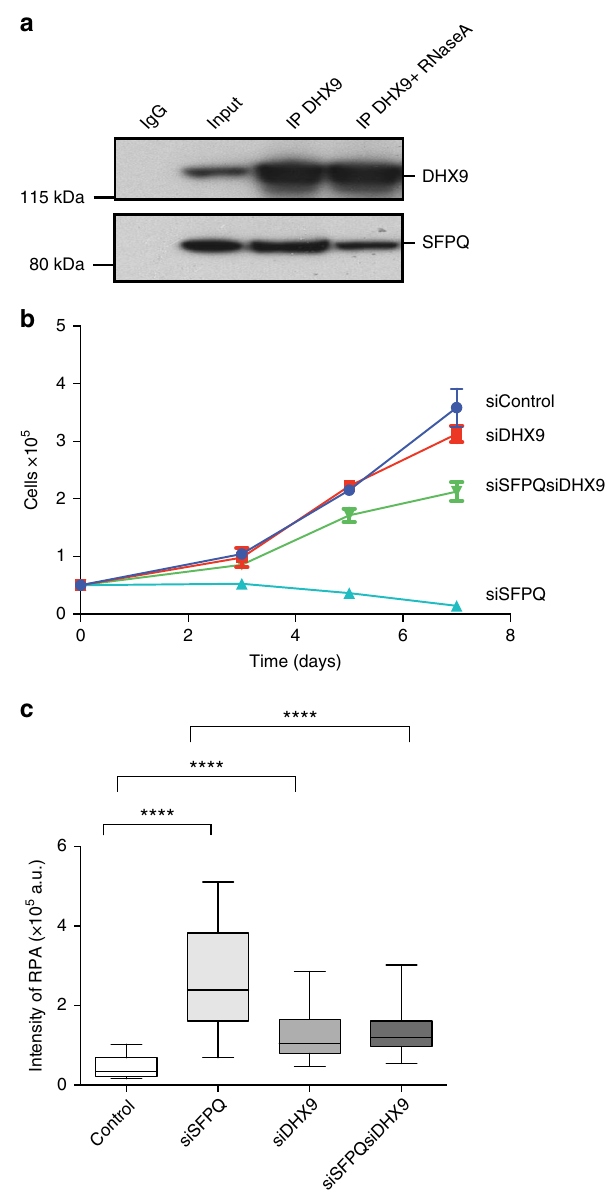
Fig. 5 DHX9 interacts with SFPQ. a Western blot showing co- immunoprecipitation of SFPQ with DHX9 from Hela cell nuclear extract. Control sample treated with RNaseA is indicated. Input sample and IgG control are also shown. b Knockdown of DHX9 suppresses the growth defect in SFPQ-depleted cells (siSFPQ8). Cell number was measured 48 h after transfection with siRNA (time 0) and again after 3, 5, and 7 days. c Knockdown of DHX9 suppresses replication stress in SFPQ-depleted cells. Fluorescence intensity of RPA foci was measured in n > 90 cells, 72 h after transfection with the indicated siRNA. Statistical signi fi cance was determined using Mann – Whitney test (**** p < 0.0001). Box and whisker plots display median, upper and lower quartile range with whiskers depicting lowest and highest